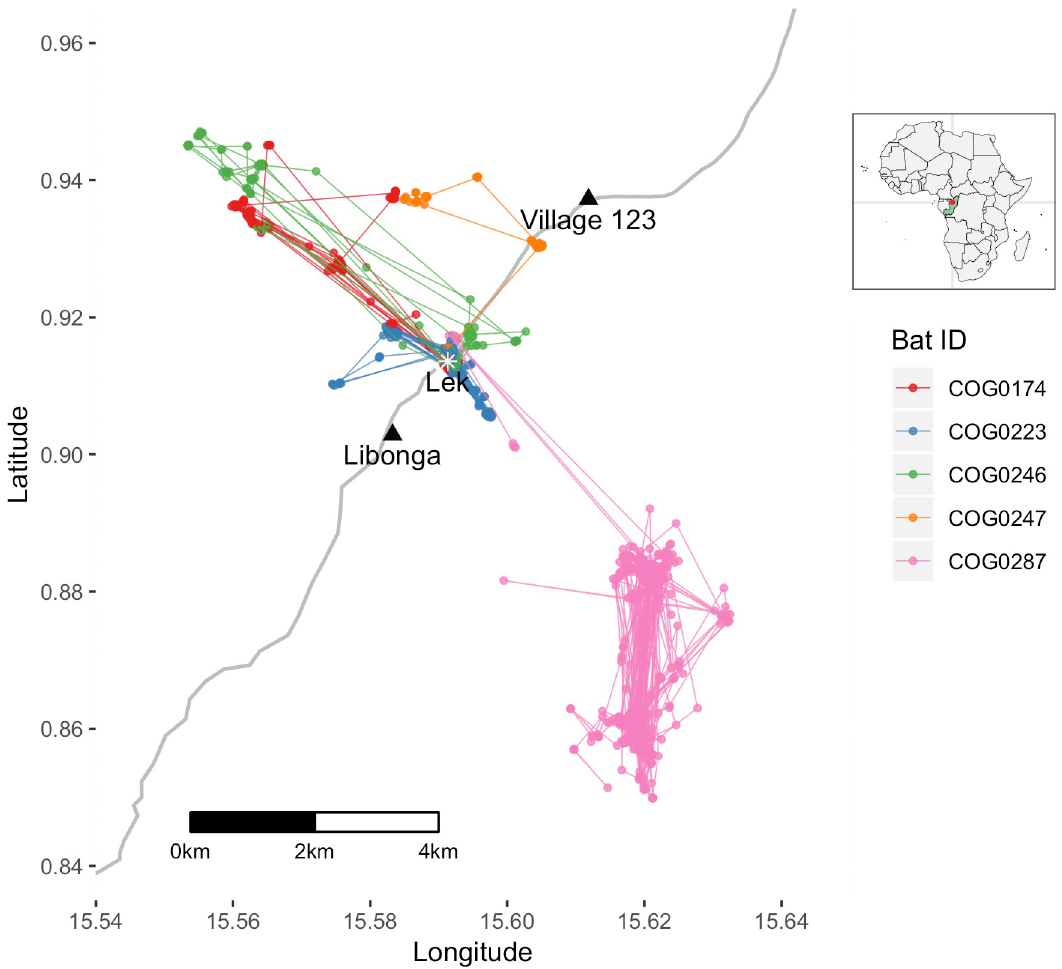
Fig 2. GPS tracking of five bats. Locations and movement and of bats beginning mid-April 2018. The main north-south paved N2 highway is shown in grey (inset map from R package: rworldmap). The estimated center of lek activity is located at the star and locations of the two nearby villages are shown (black